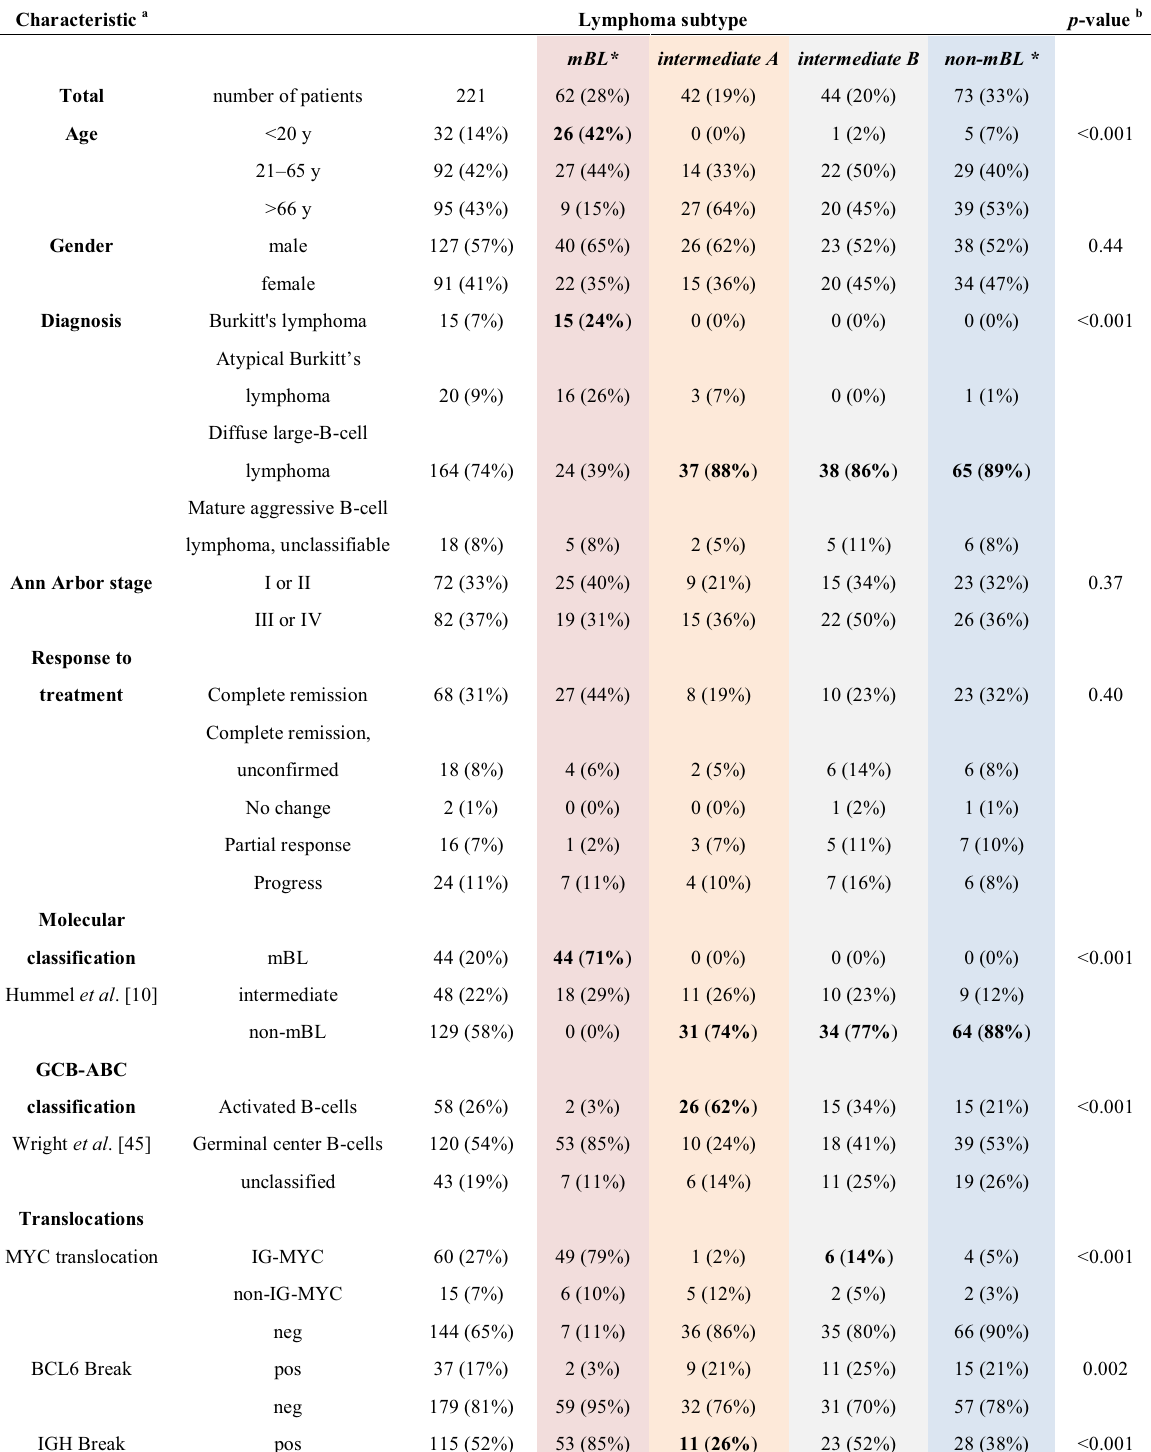
Table 1. Phenotypic and molecular characterization of the four new